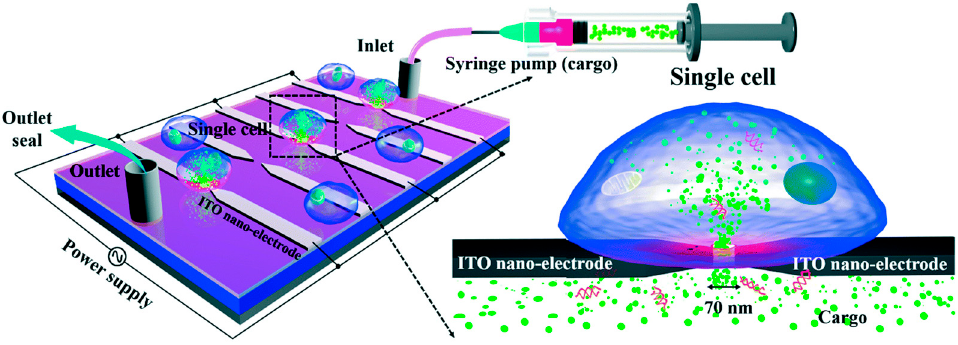
Figure 16. Schematic diagram of the nano-localized single-cell nano-electroporation platform. Reprinted with permission from ref. [116]. Copyright © 2020 The Royal Society of Chemistry.